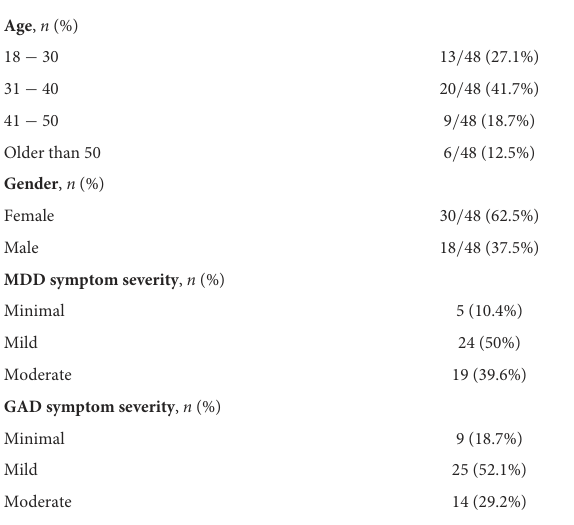
TABLE 2 Participant demographic characteristics and baseline assessment